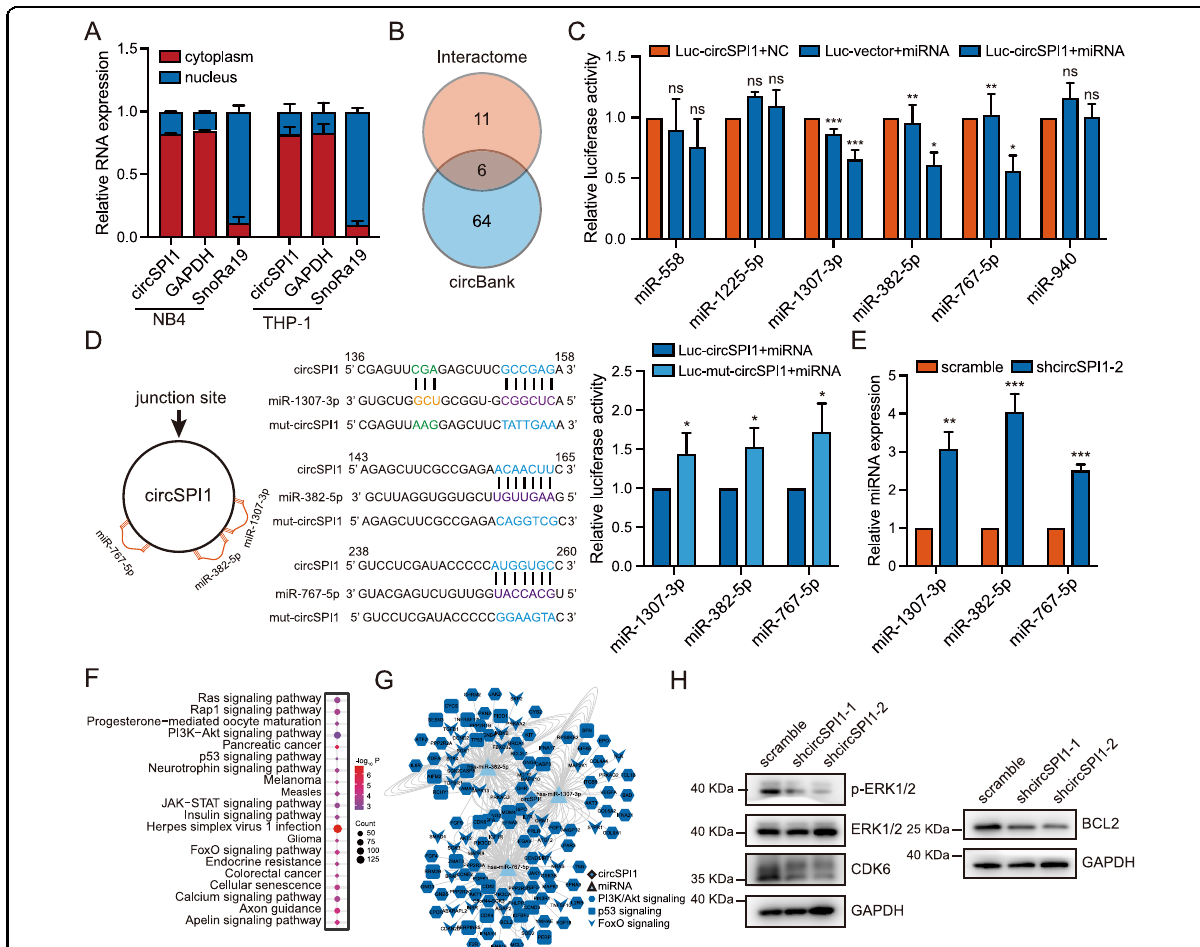
Fig. 5 CircSPI1 interacts with microRNAs to regulate apoptosis functional signaling pathways. A The subcellular localization of circSPI1 was analyzed by RT-qPCR. B Potential targeted miRNAs of circSPI1 were predicted by the circBank and Interactome databases. C Luciferase activity assay detected the miRNAs bound by circSPI1. HEK-293T cells were transfected with the circSPI1 luciferase reporter plasmid and predicted miRNA mimics. The luciferase activity was detected 24 h after transfection. D Luciferase activity of mutant circSPI1 was analyzed in HEK-293T cells transfected with the three miRNA mimics. The schematic diagram delineated putative binding sites of miR-1307-3p, miR-382-5p, and miR-767-5p on circSPI1 (left two panels). The luciferase activity was detected 24 h after transfection (right panel). E The expression levels of the three miRNAs were detected with or without circSPI1 knockdown by RT-qPCR . F Enriched KEGG terms for the three miRNA-regulated genes. G Global view of the circSPI1 and three miRNAs-associated ceRNA network. H The protein levels of apoptosis-related factors were detected with or without circSPI1 knockdown by western blotting. The original gels and three replicates are presented in Supplementary Fig. 4. All bar graphs represent the average of three independent replicates and error bars are SD, * P < 0.05, ** P < 0.01, *** P < 0.001, ns no signi fi